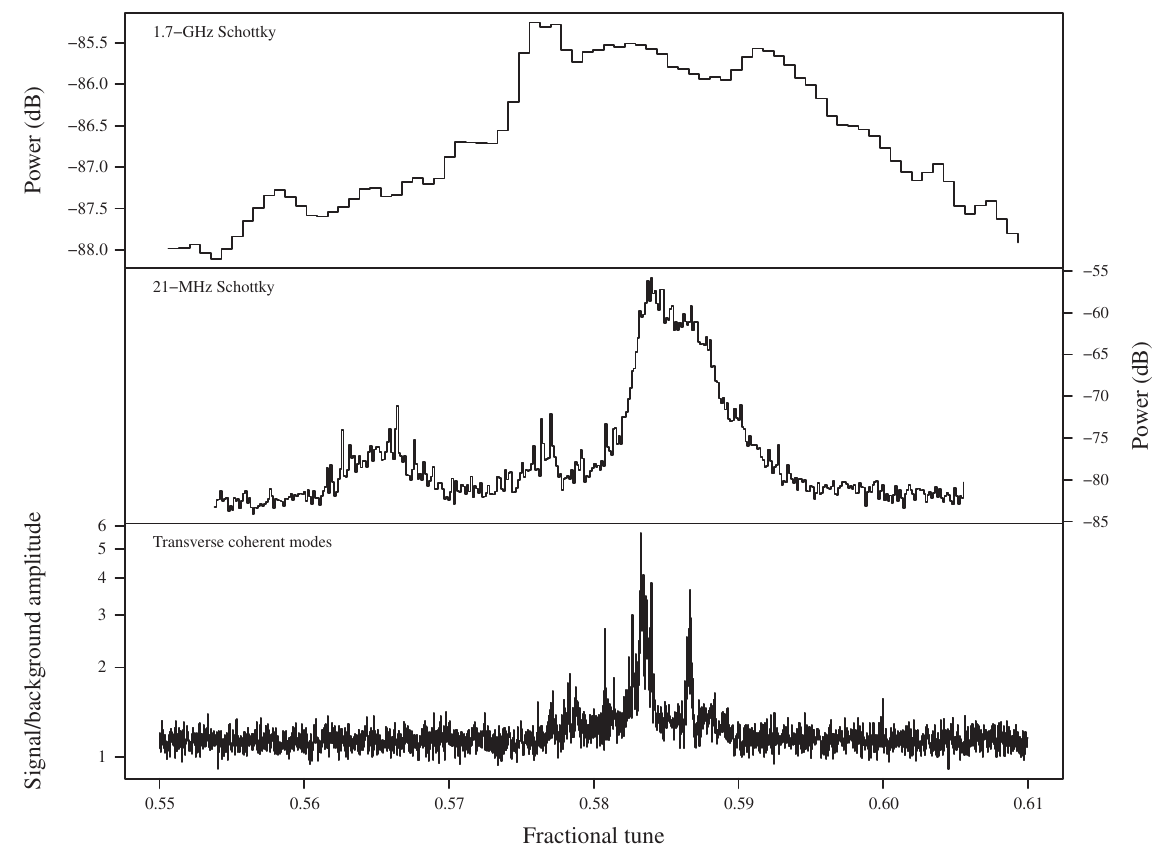
FIG. 12. Comparison of Schottky and coherent spectra during dedicated 3-on-3 Store